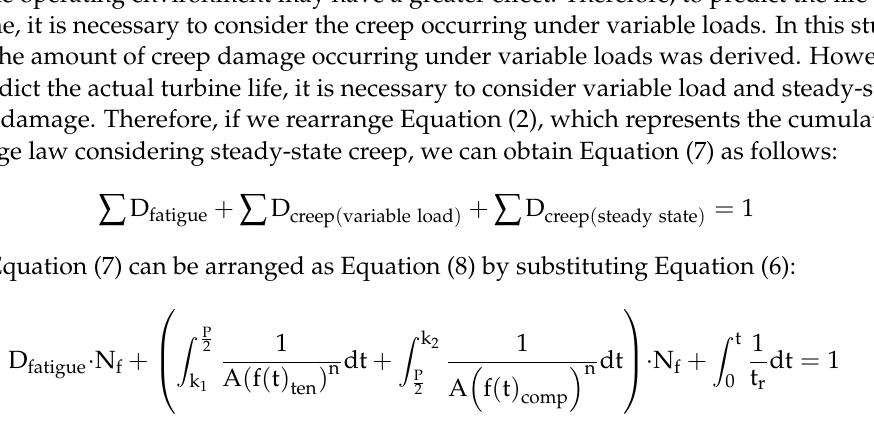
Figure 11. Ratio of damage caused by creep ( Σ D creep ) at 900°C.